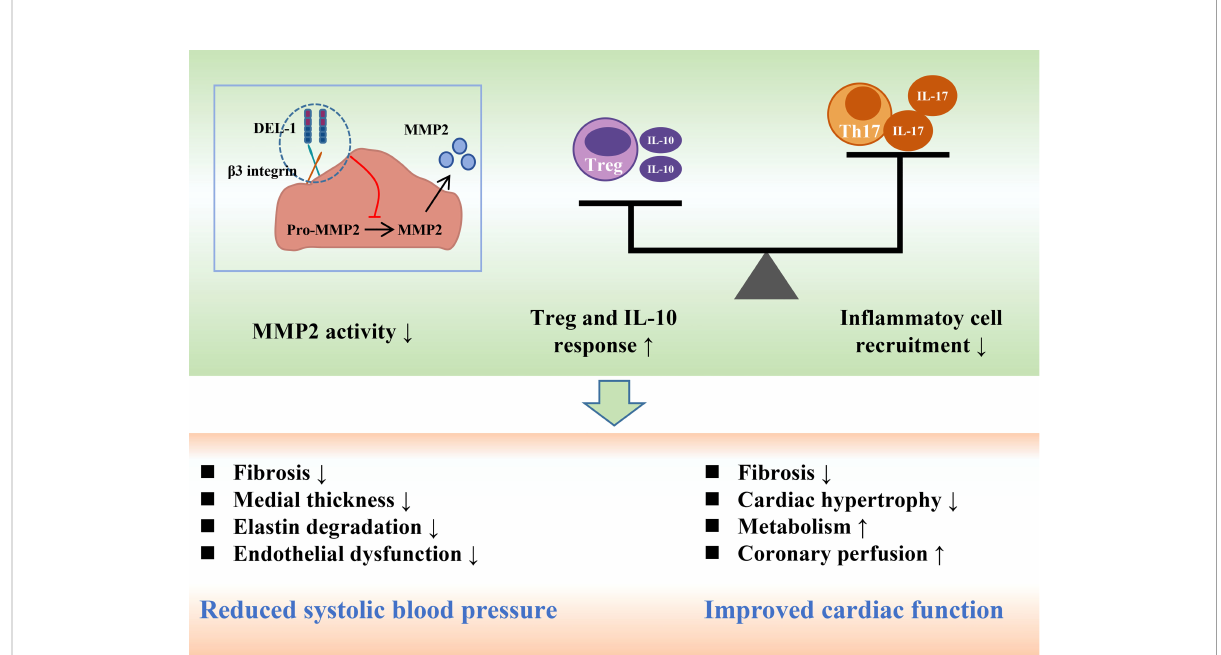
FIGURE 4 DEL-1 reduces blood pressure and maintains cardiac function by inhibiting MMP2 activity, reducing in fl ammatory cell in fi ltration and enhancing Treg and IL-10 responses. DEL-1, developmental endothelial locus-1; MMP2, matrix metallopeptidase 2; Th17, T helper 17 cell; Treg, T regulatory cell; IL,